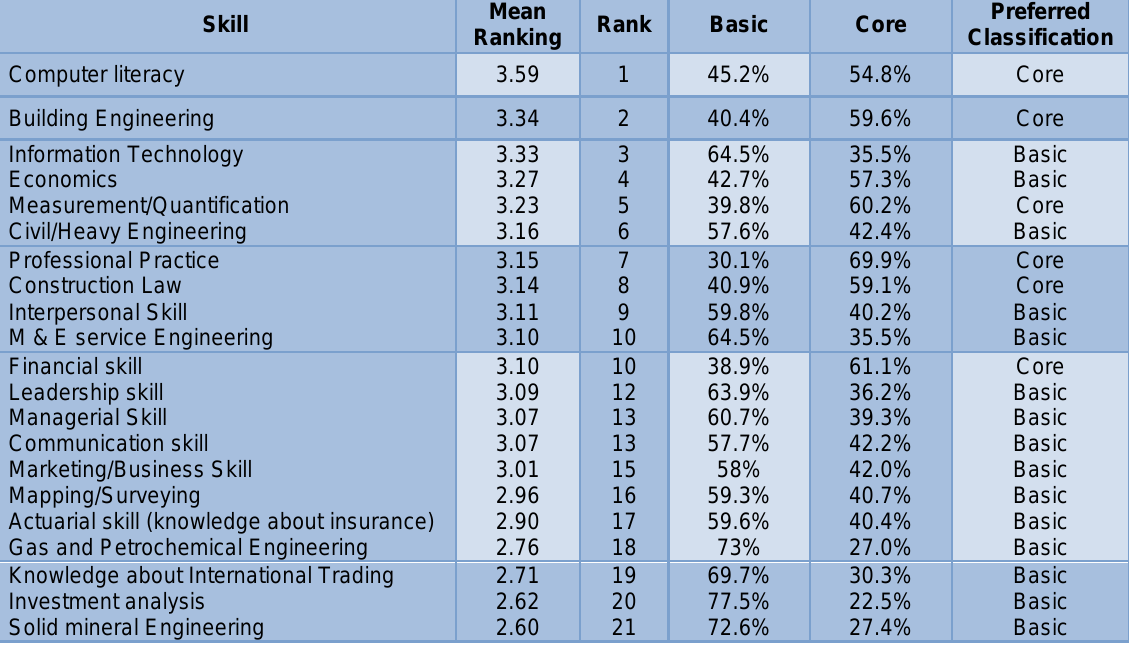
Table 2 Classification of Skills Required of Quantity